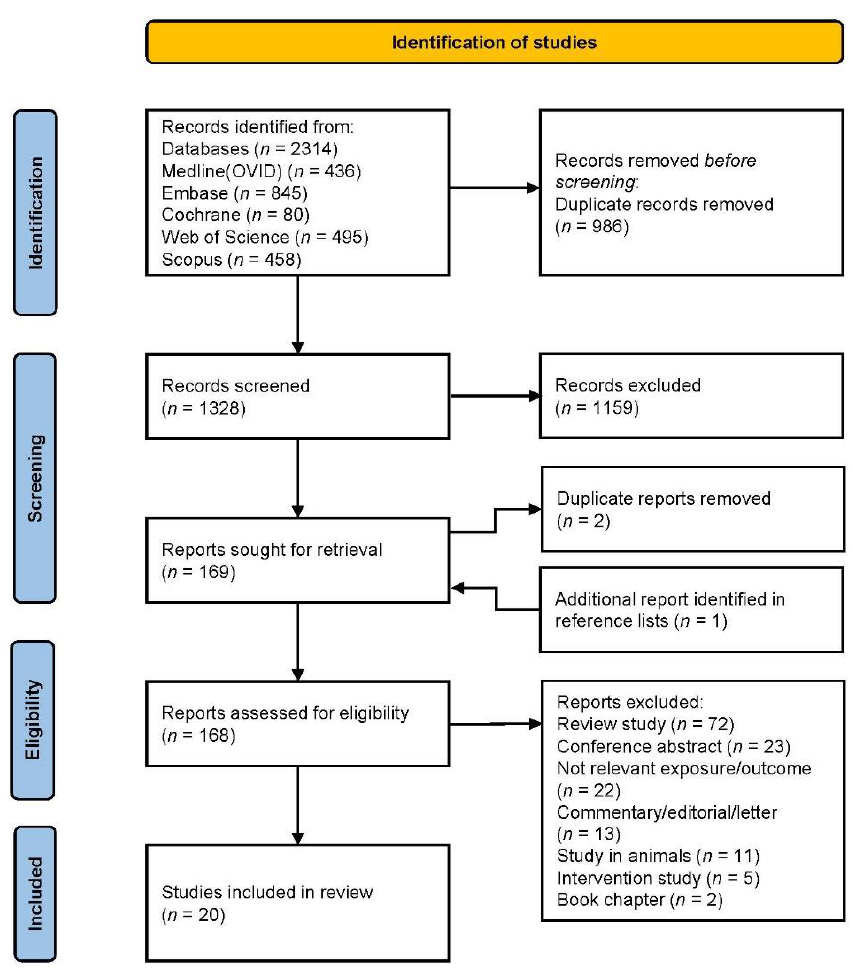
Figure 1. PRISMA flowchart of the study selection.